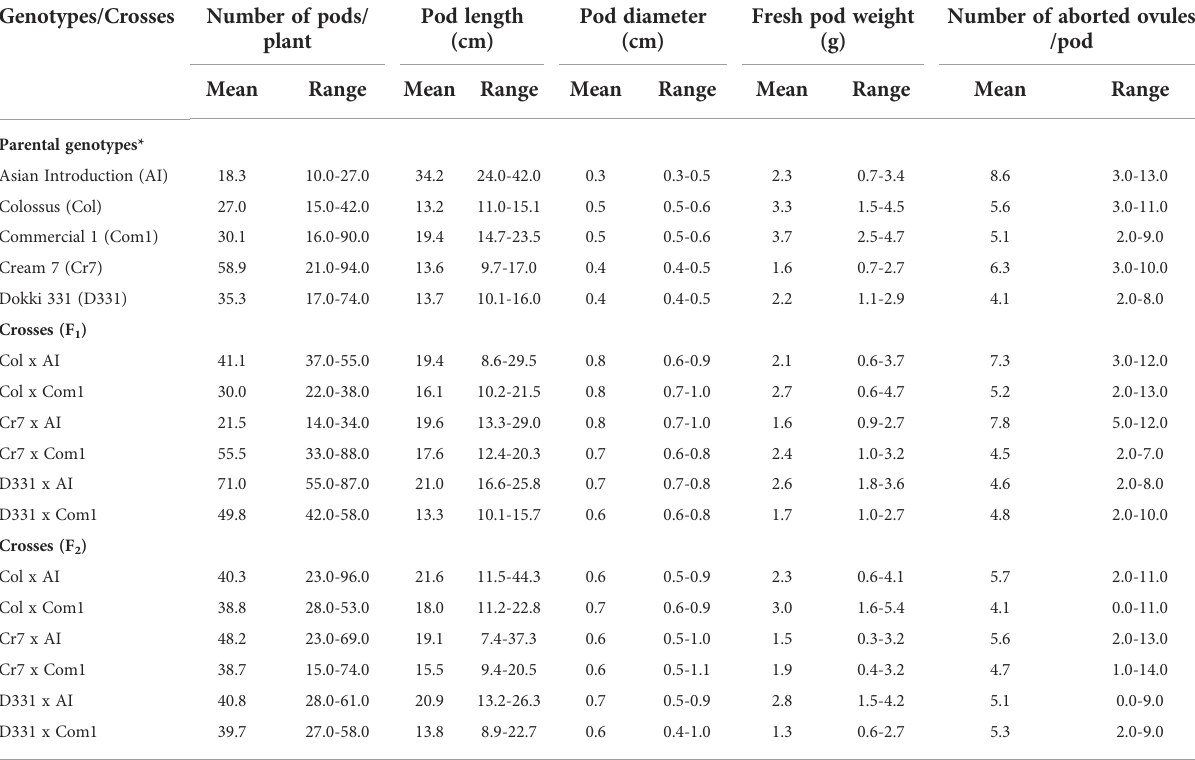
TABLE 3 Mean and range of number of pods/plant, pod length (cm), pod diameter (cm), fresh pod weight (g), and number of aborted ovules/pod of six cowpea crosses produced from fi ve different genotypes in F 1 , F 2 generations.